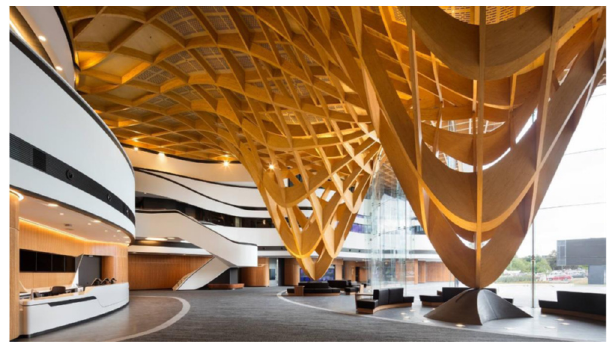
Figure 2. Bunjil Place, Melbourne.